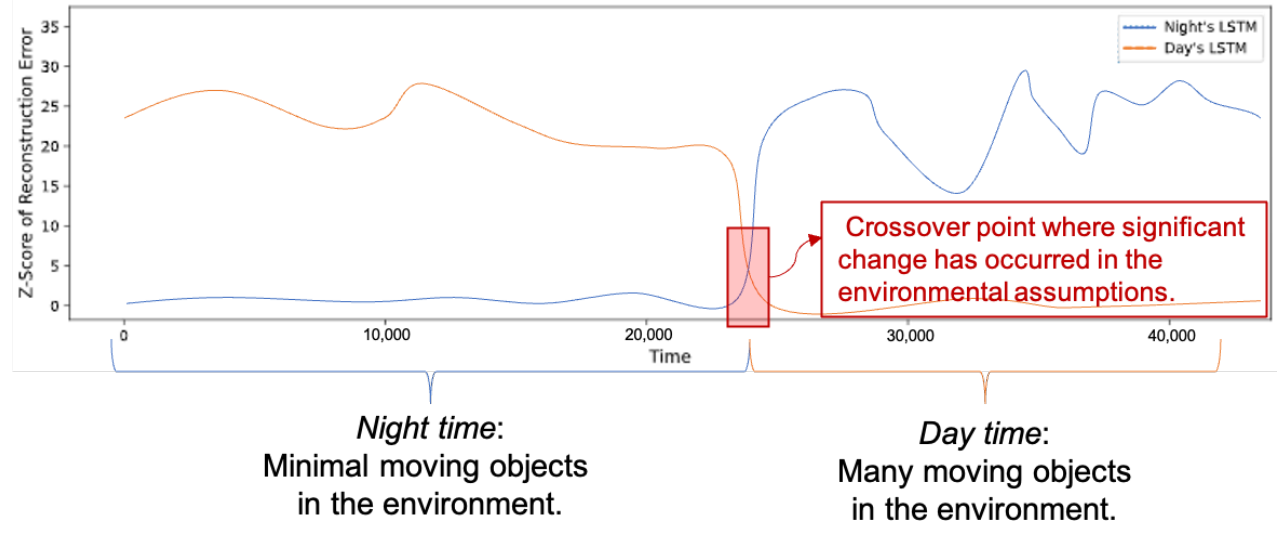
Figure 4. Starting at midnight, the Z-scores of reconstructed RSSI values corresponding to the transmitting node s using the two trained models (for day and night) are tracked. At about dawn, when occupants started to wake up and move about, the error rate of the night model significantly increases while the day model’s error rate drops